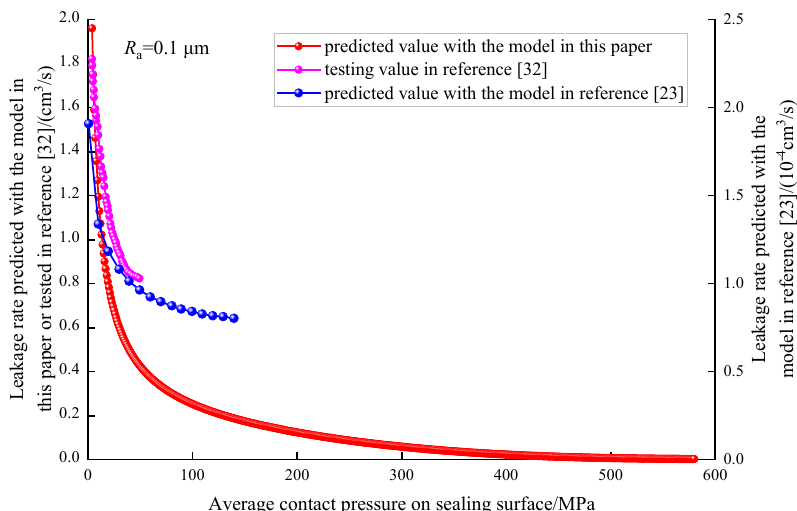
Figure 7. Comparison of leakage rates.